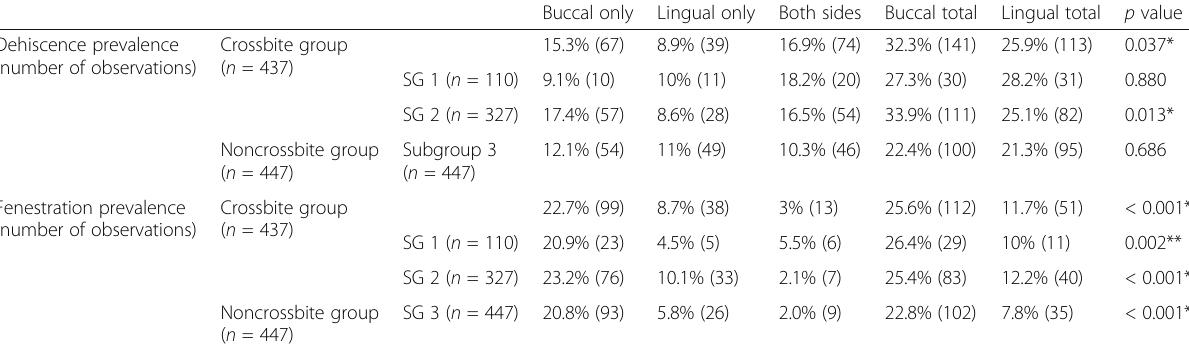
Table 8 Comparison of the bony defect prevalence between the buccal and lingual sides Buccal only Lingual only Both sides Buccal total Lingual total p value Dehiscence prevalence Crossbite group (number of observations) ( n =